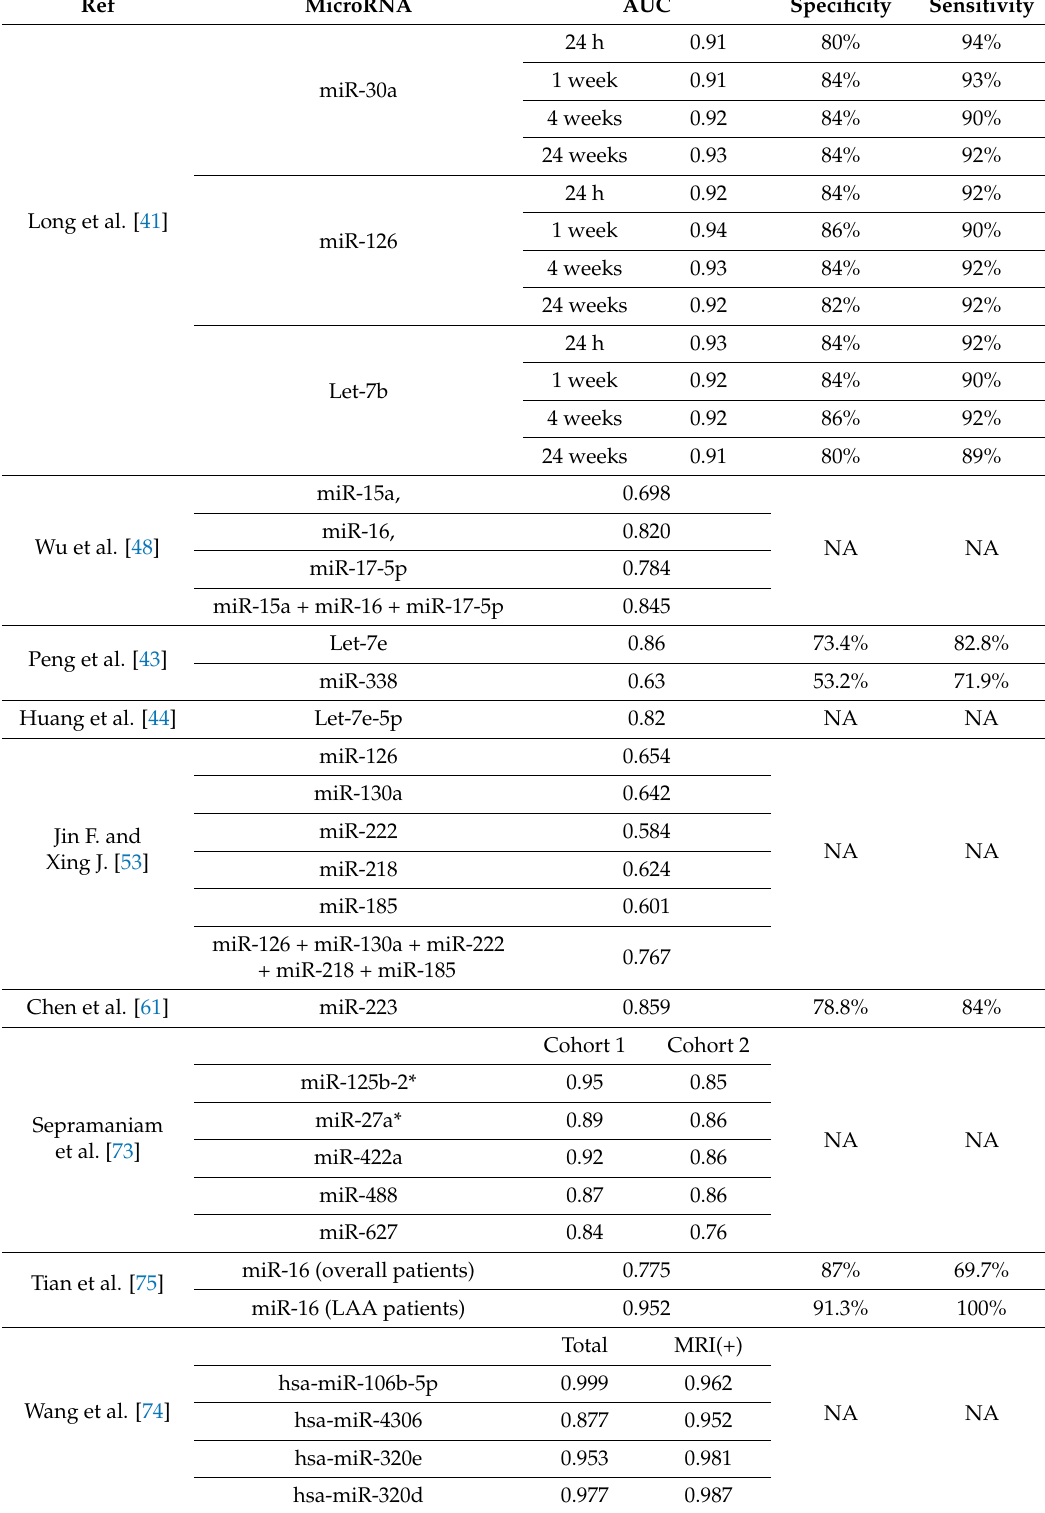
Table 2. The results of area under the receiver operating characteristic curves from human